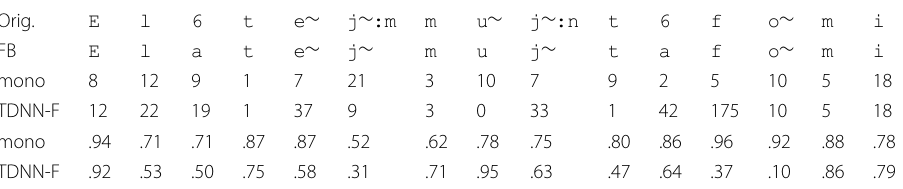
Table 9 Original (orig) and FalaBrasil (FB) SAMPA-based phonetic transcriptions for the phrase “ ela tem muita fome ”